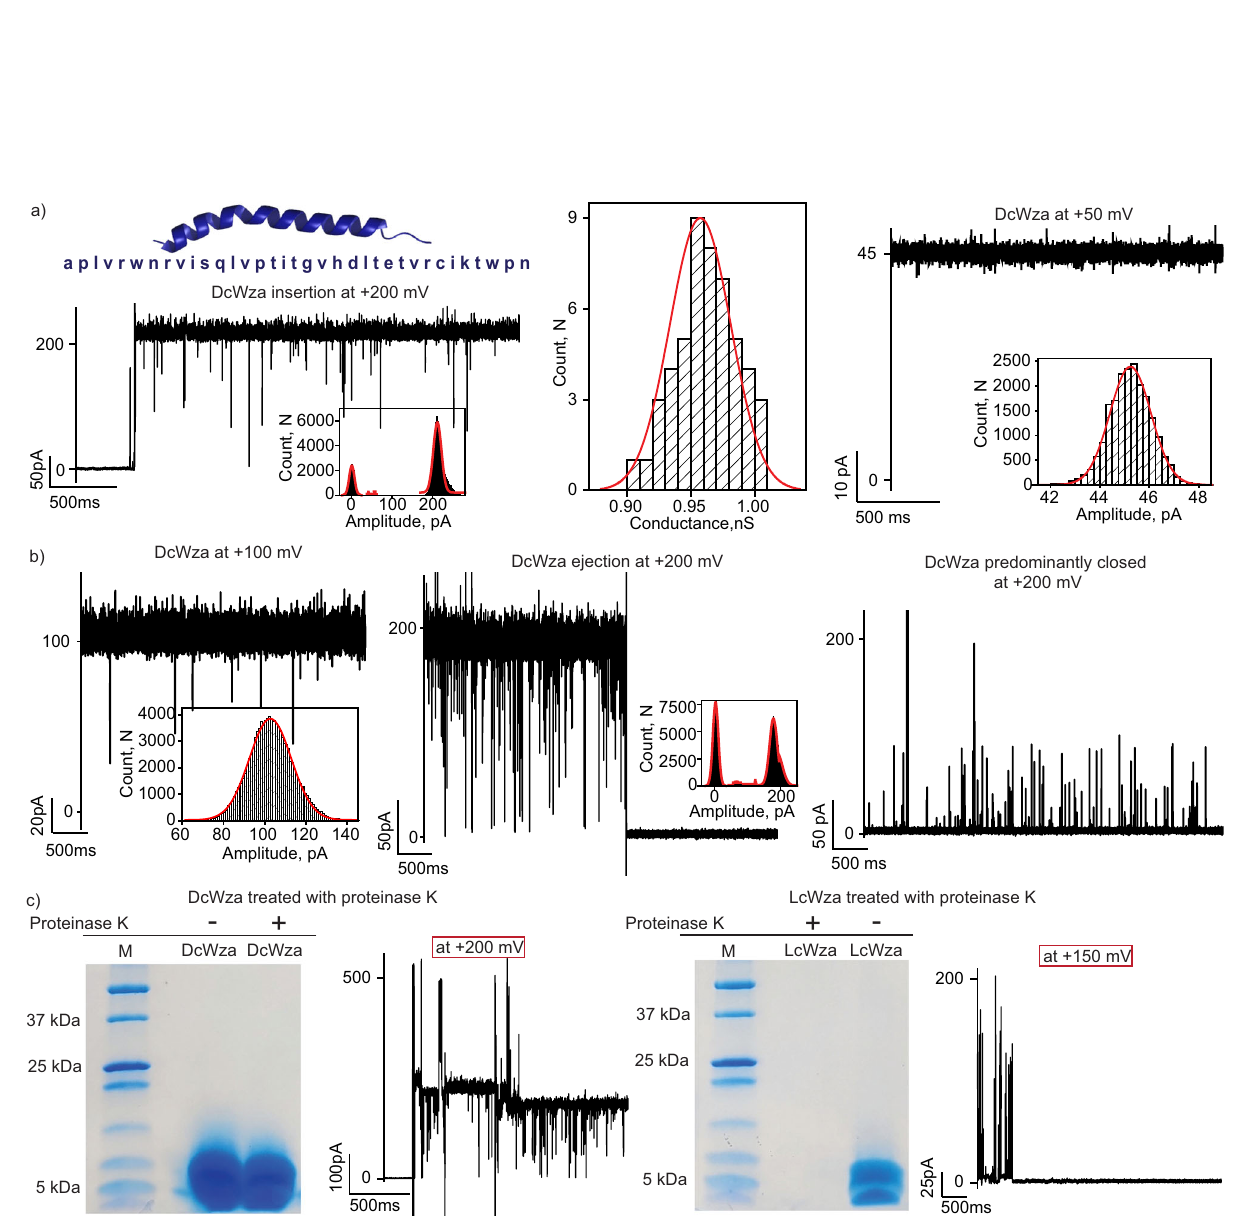
Fig. 5 | Single-channel properties ofDcWza. a DcWza peptide sequence, single DcWza insertion at +200mV and corresponding current amplitude histogram. The mean unitary conductance histogram for DcWza insertion at +200mV was obtained by fi tting the distribution to a Gaussian ( n = 50). Single DcWza in a stable conductance state at +50mV and corresponding current amplitude histogram. b Single DcWza at +100mV and ejection of DcWza from the membrane at +200mV with corresponding current amplitude